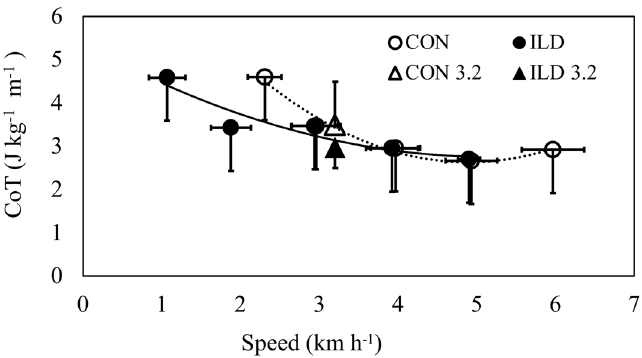
Figure 1. Cost of Transport as a function of absolute speed in patients with interstitial lung disease (ILD, filled circles) and controls (CON, empty